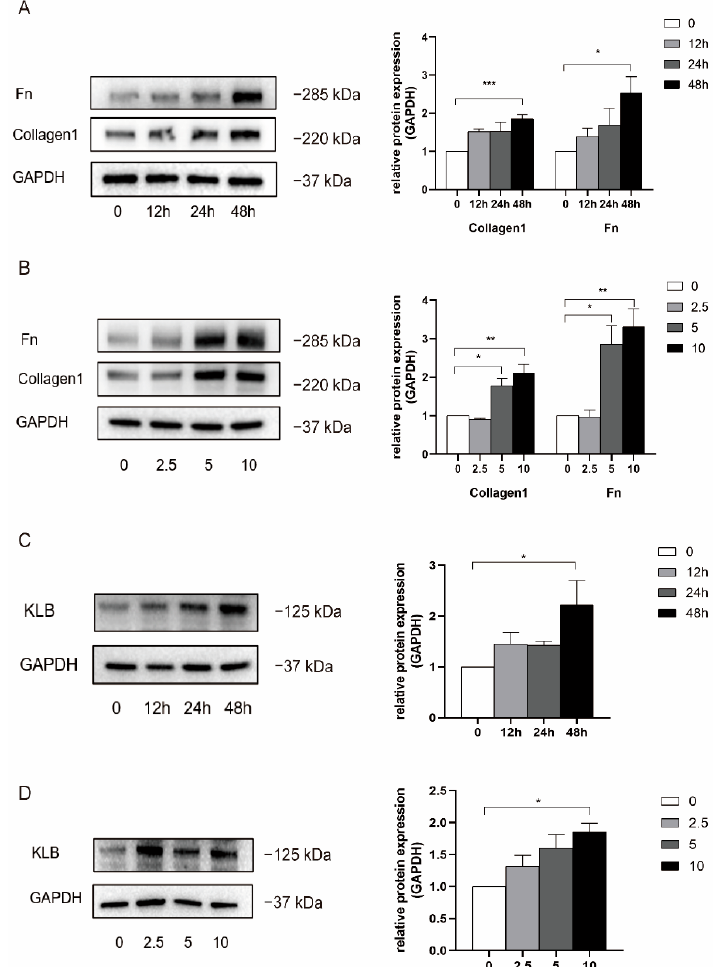
Figure 3. TGF- β 1 was used to stimulate HESCs to construct an IUA cell model and detect the expression of KLB. ( A ) Western blot was used to detect the expression of Collagen I and FN in HESCs stimulated with TGF- β 1 at the concentration of 10 ng/mL for 0, 12, 24, and 48 h. It was found that the expression of Collagen I and FN increased in a statistically significant manner when treated with 10 ng/mL for 48 h. ( B ) The expression of Collagen I and FN in HESCs stimulated with TGF β 1 at the concentrations of 0, 2.5, 5, and 10 ng/mL for 48 h was detected by Western Blot. It was found that the expression of Collagen I and FN was significantly increased when the cells were treated with 5 ng/mL and 10 ng/mL. ( C ) The expression of KLB in HESCs stimulated with TGF- β 1 at the concen-